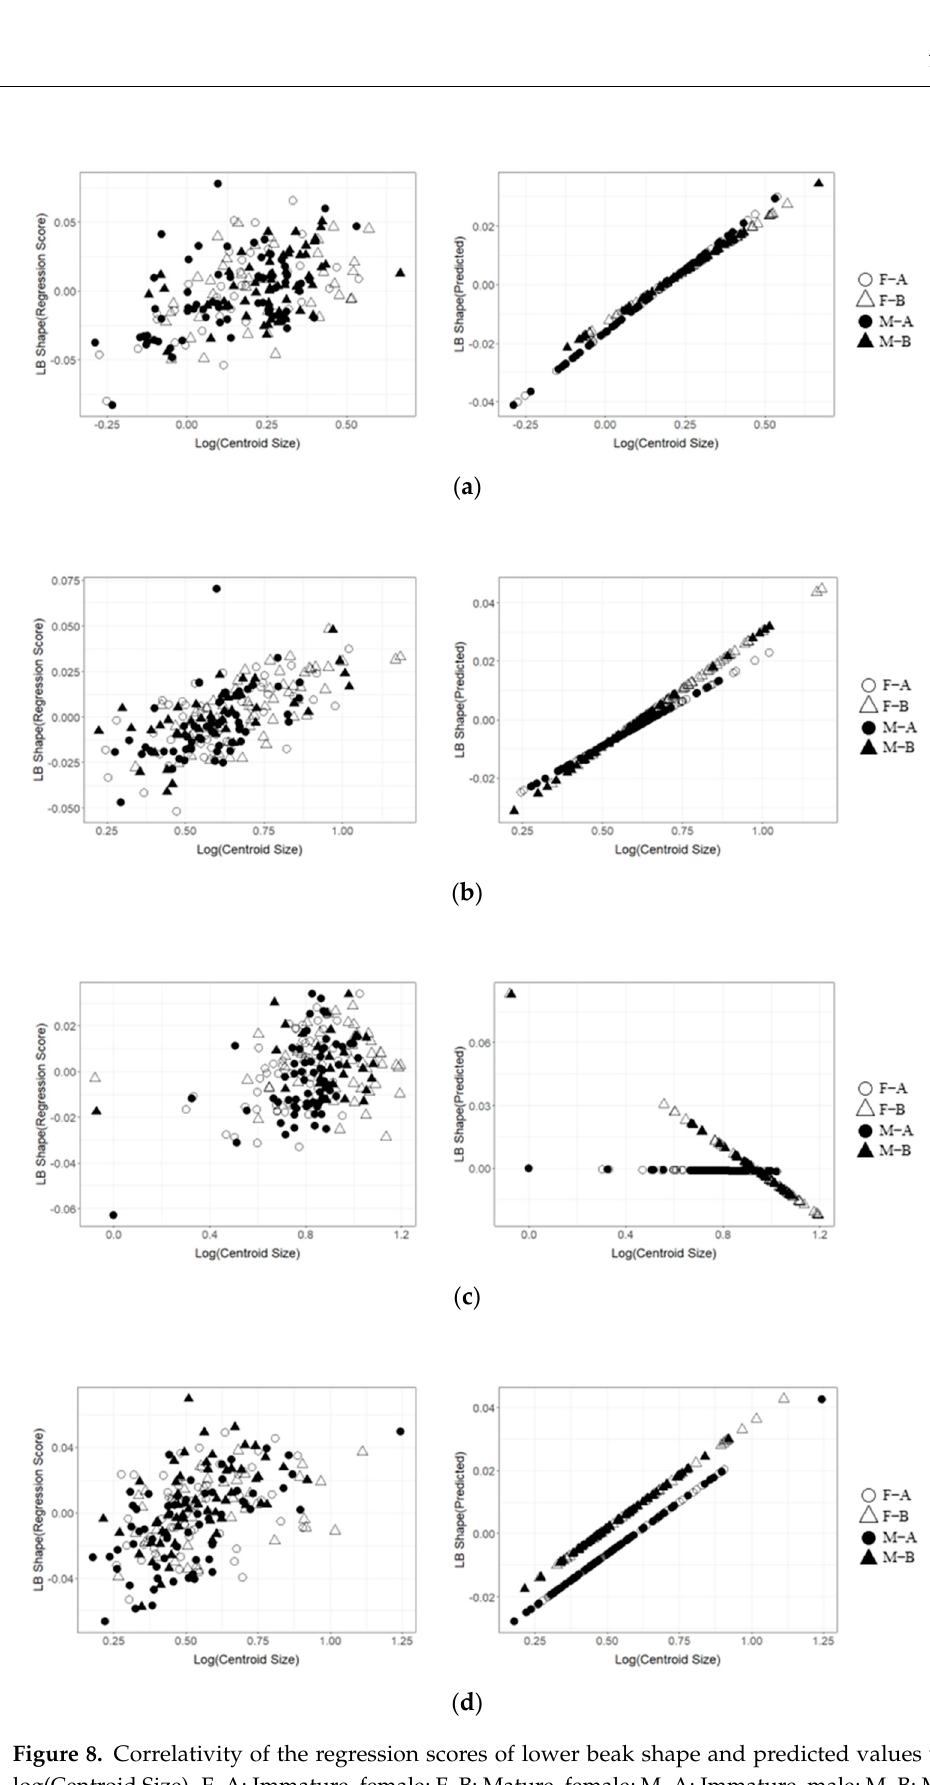
Figure 8. Correlativity of the regression scores of lower beak shape and predicted values versus log(Centroid Size). F–A: Immature, female; F–B: Mature, female; M–A: Immature, male; M–B: Mature, male. ( a ) Octopus minor . ( b ) Uroteuthis edulis . ( c ) Sepia esculenta . ( d ) Sthenoteuthis oualaniensis